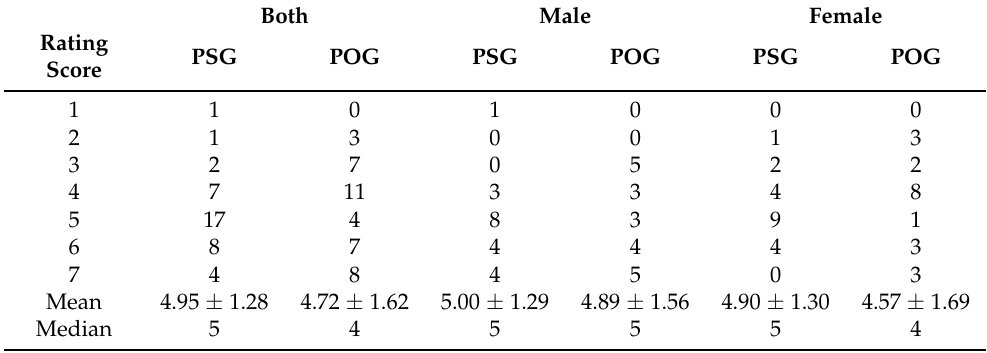
Table 6. Mean, median and occurrence of avatar rating grouped by both male and female gender. Both